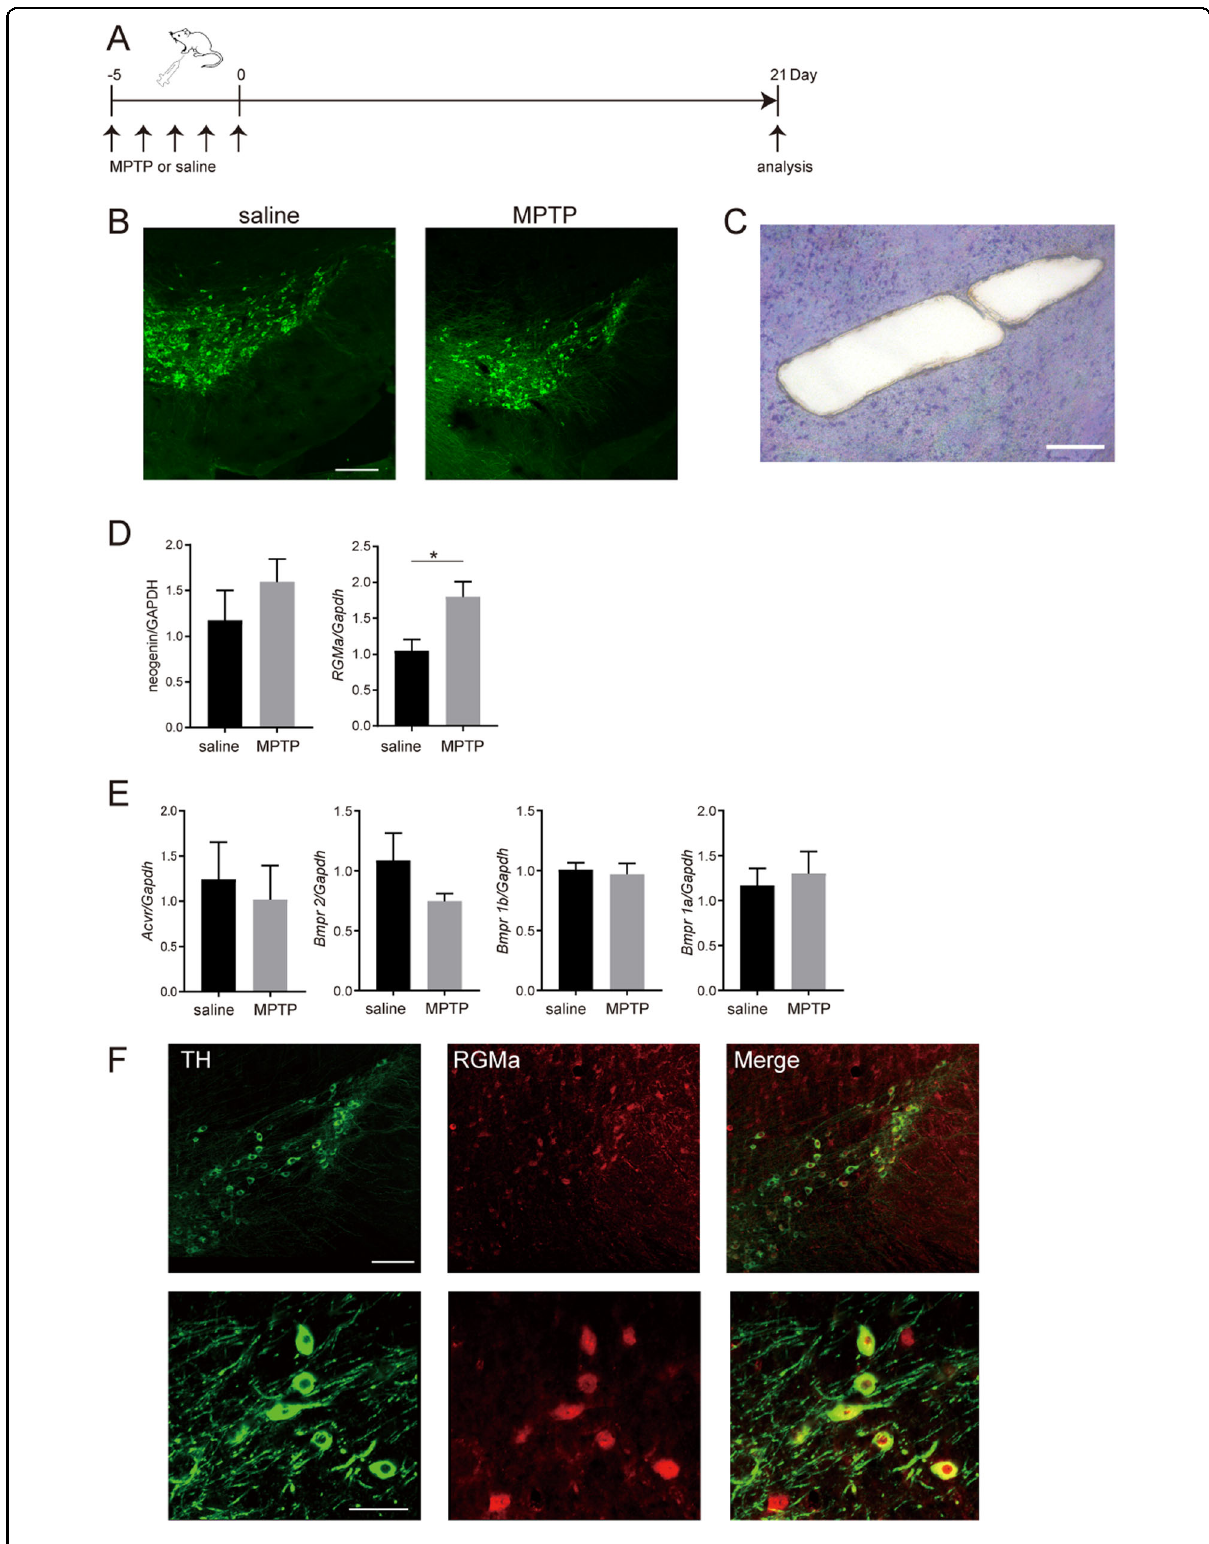
Fig. 1 (See legend on next